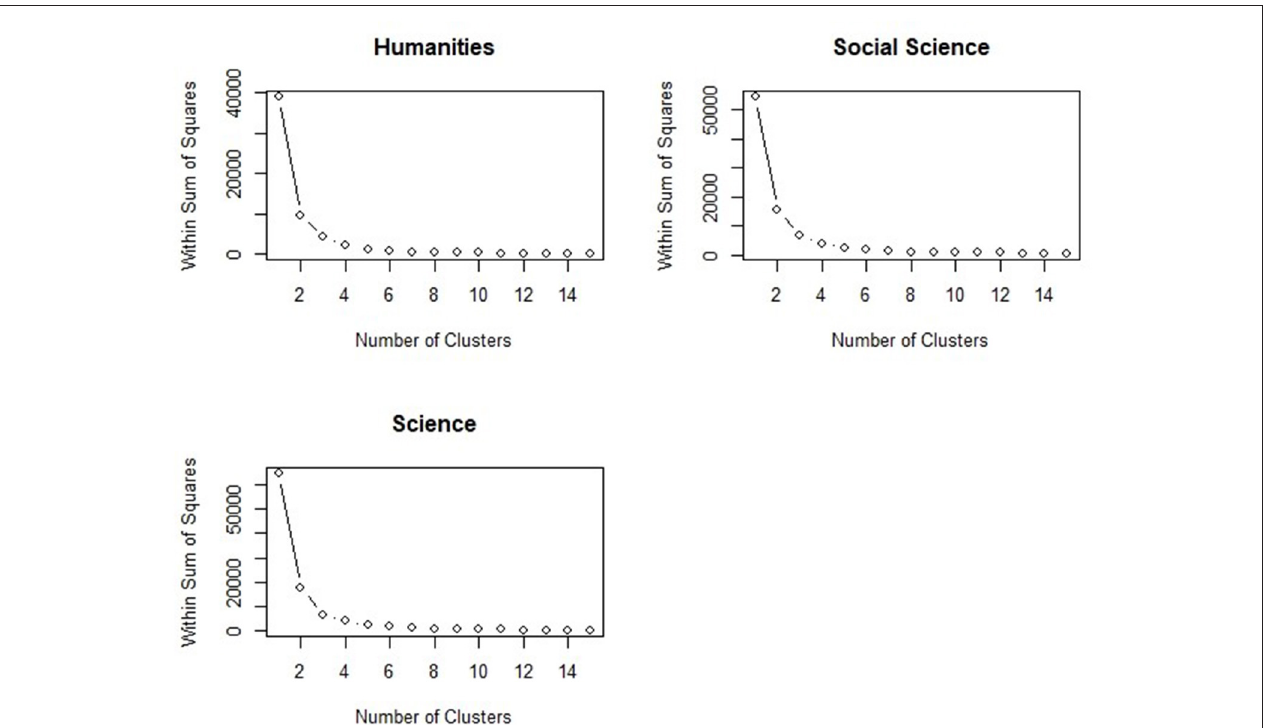
FIGURE 1 | Number of clusters chosen by within sum of